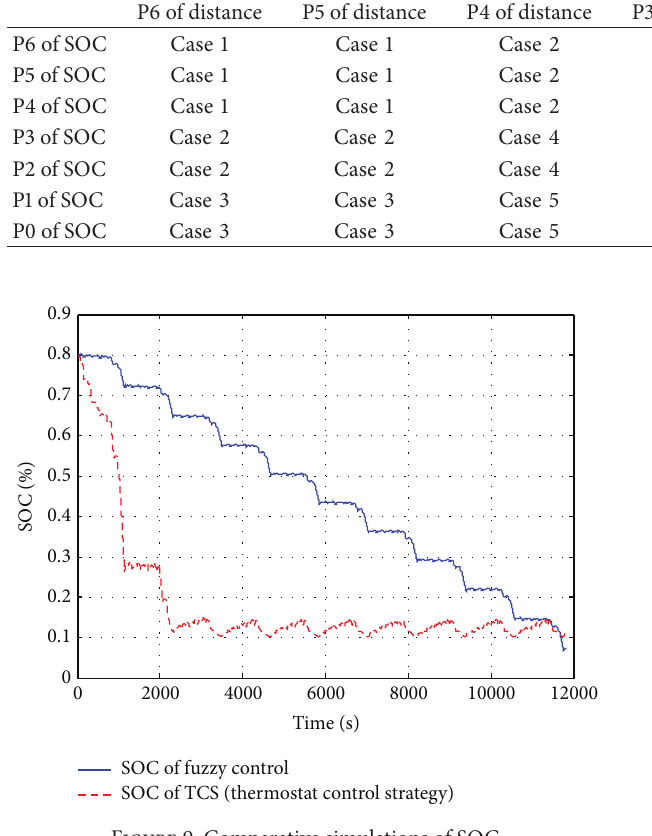
Figure 9: Comparative simulations of SOC. Figure 10: Speed profile of fuzzy